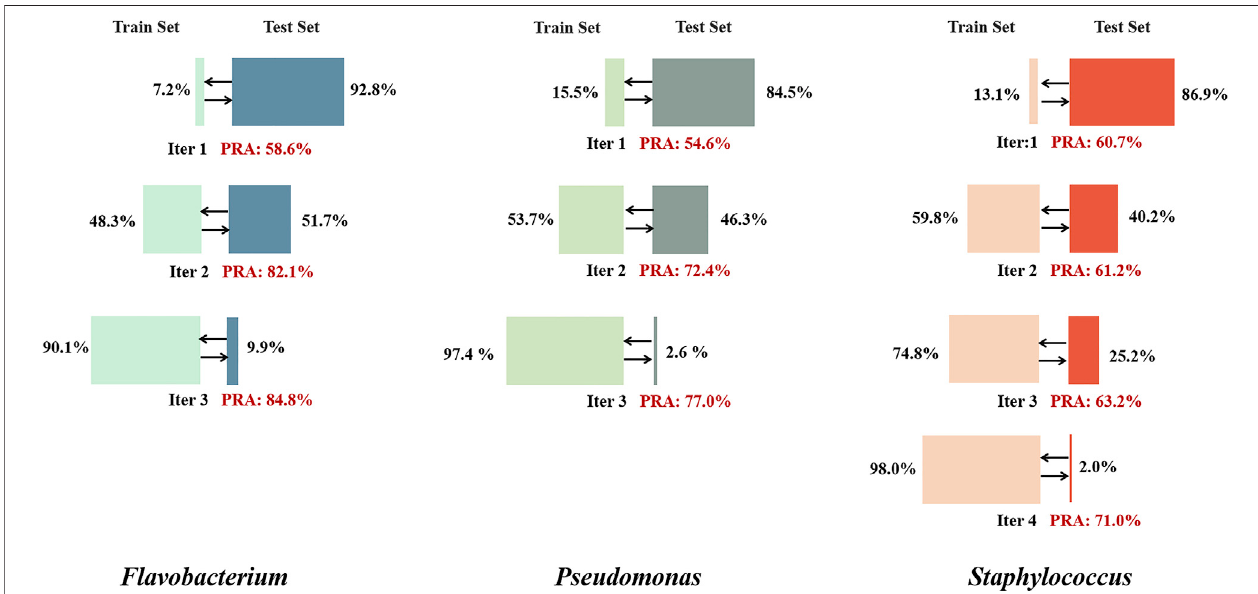
FIGURE 6 | Self-supervised learning iteration results for the three genera. In each iteration, training was performed for 50 epochs, nodes with an average PRA of less than 30% were removed from the training set, and nodes with stably assigned labels in the test set (with assignment consistency over more than 90% of epochs) were added to the training set. When the proportion of the total number of nodes included in the training set exceeded 90%, the fi nal results were